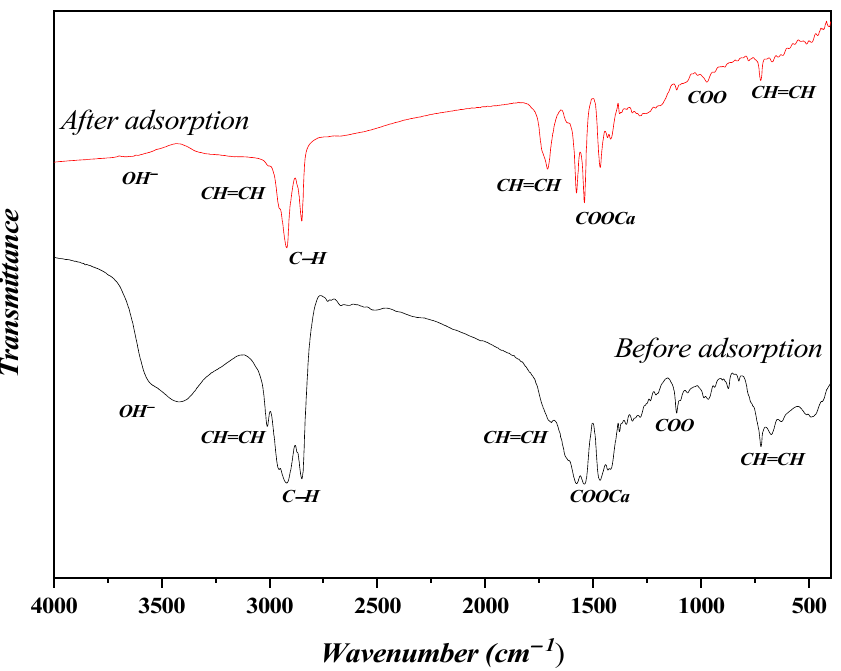
Figure 3. FTIR analysis performed on the adsorbent before and after the interaction with the MR dye.